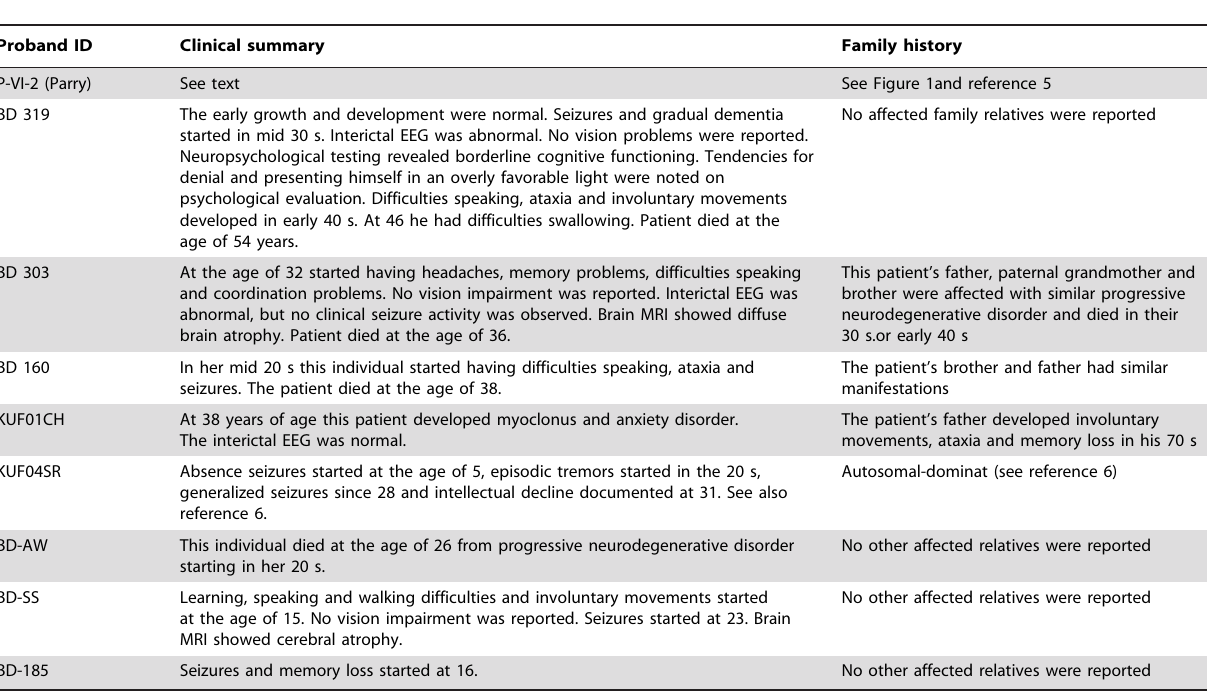
Table 1. Clinical manifestations in probands from the families or sporadic affected individuals included in the study.